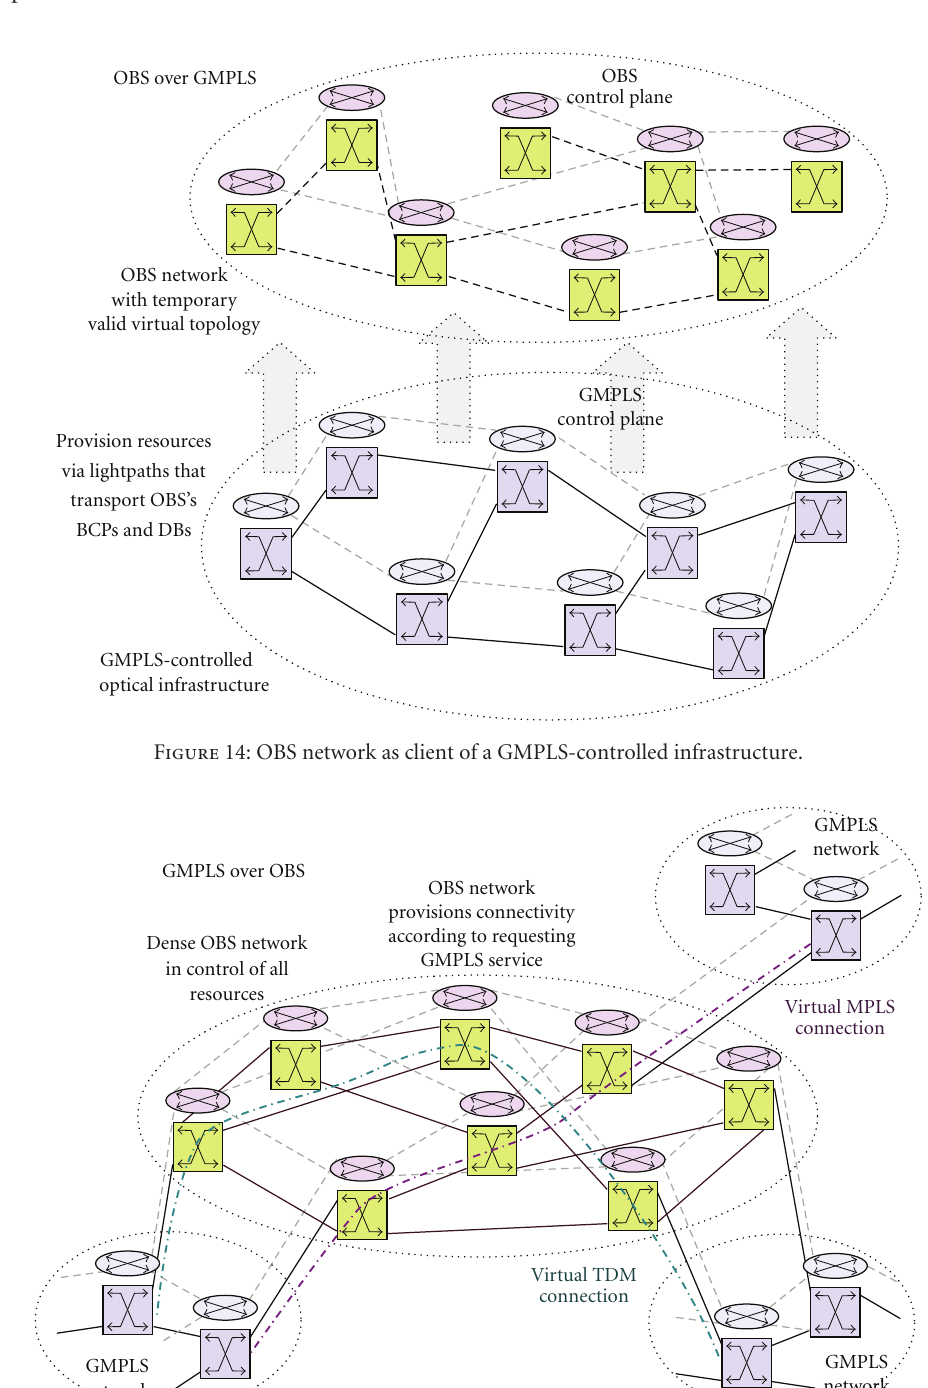
Figure 15: OBS-controlled optical core infrastructure providing di ff erent services able to seamlessly tunnel di ff erent GMPLS